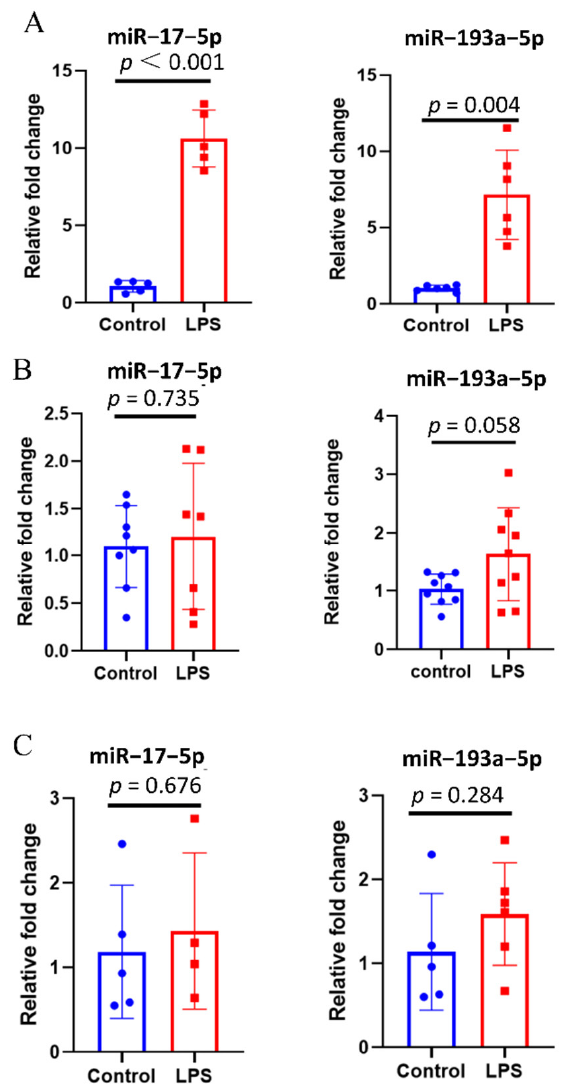
Figure 3. Inflammatory stimuli increase the expression of miR–17–5p and miR–193a–5p in EVs derived from macrophages. ( A ) Comparison of the expression of miR–17–5p and miR–193a–5p in EVs from THP-1-derived macrophages (tMACs-EVs, n = 5–6) between two groups. ( B ) Comparison of the expression of miR–17–5p and miR–193a–5p in tMACs (n = 7–9) between two groups. ( C ) Comparison of the expression of miR–17–5p and miR–193a–5p in EVs-free supernatants derived from tMACs (tMACs-EVs-free supernatants, n = 4–6) between two groups. Data presented as a relative fold change for each miRNA. Box plots are displayed, where the horizontal bar represents the median, the box represents the IQR, and the whiskers represent the maximum and minimum values. Comparisons were made using the unpaired t test.